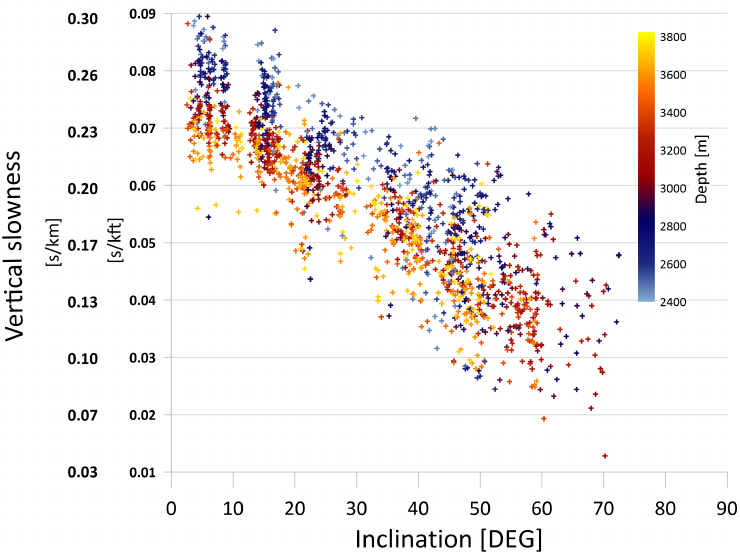
Figure 15. Vertical slowness polarization graph for all offsets and depth points used for